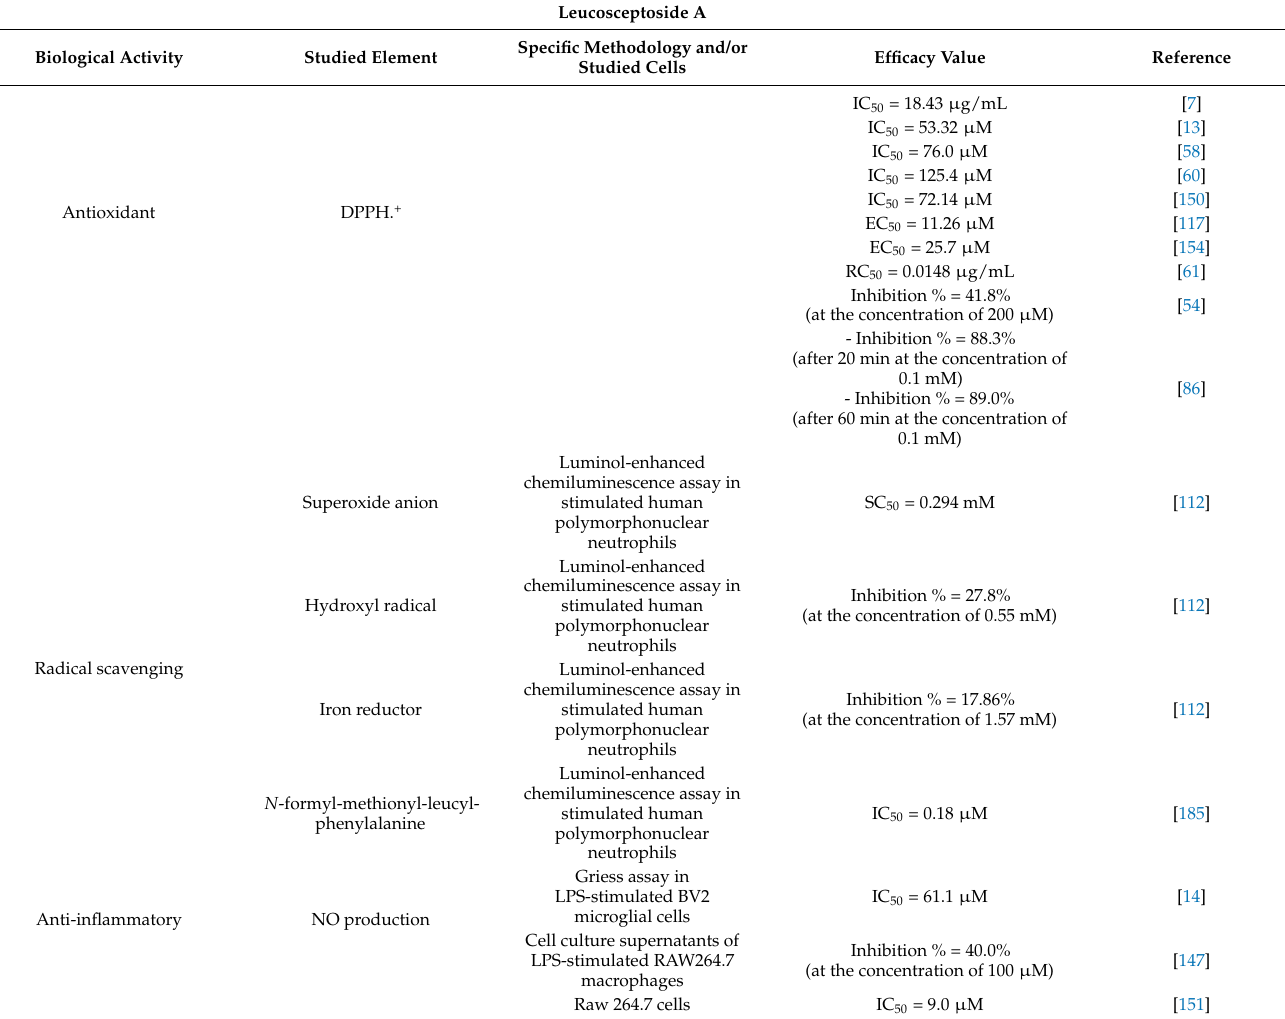
Table 3. Summary of the biological activities and efficacy values of leucosceptoside A. Leucosceptoside